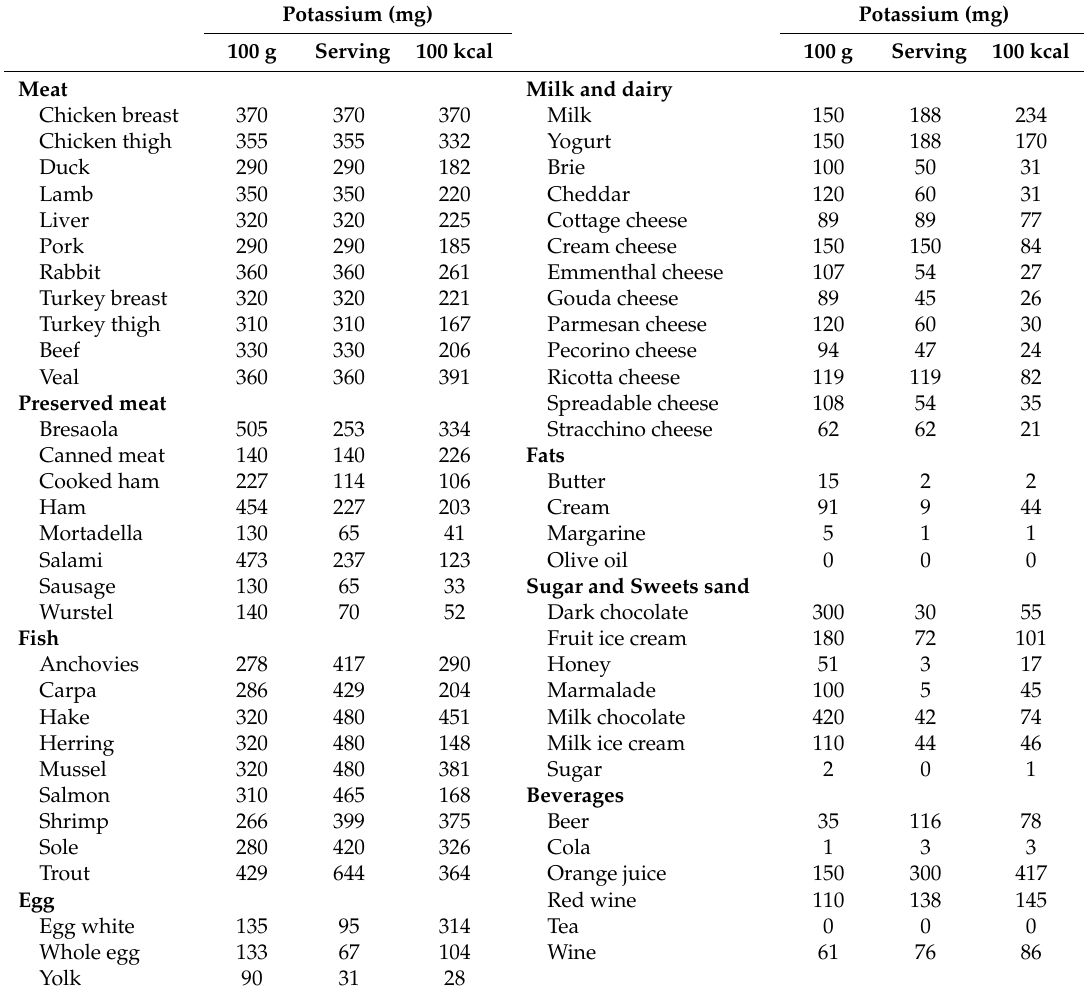
Table 2. Potassium content of animal-origin food, beverages, sugar and sweets and fats.